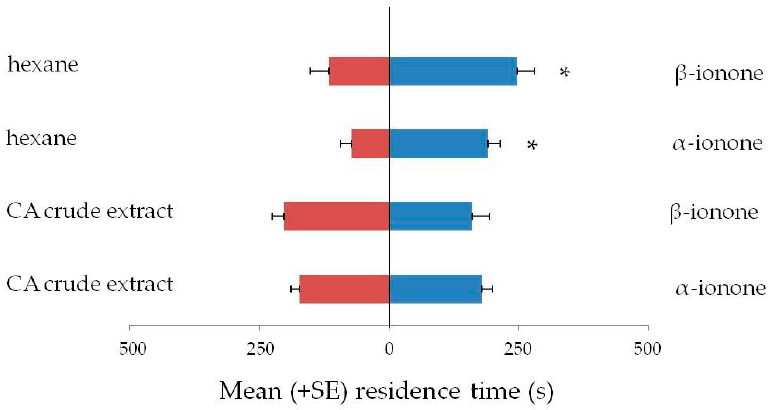
Beetles showed an attraction response toward both α -ionone (t = 4.02; df = 29; p < 0.01; N = 30) and β -ionone compared to hexane (t = 2.55; df = 29; p = 0.01; N = 30). Both